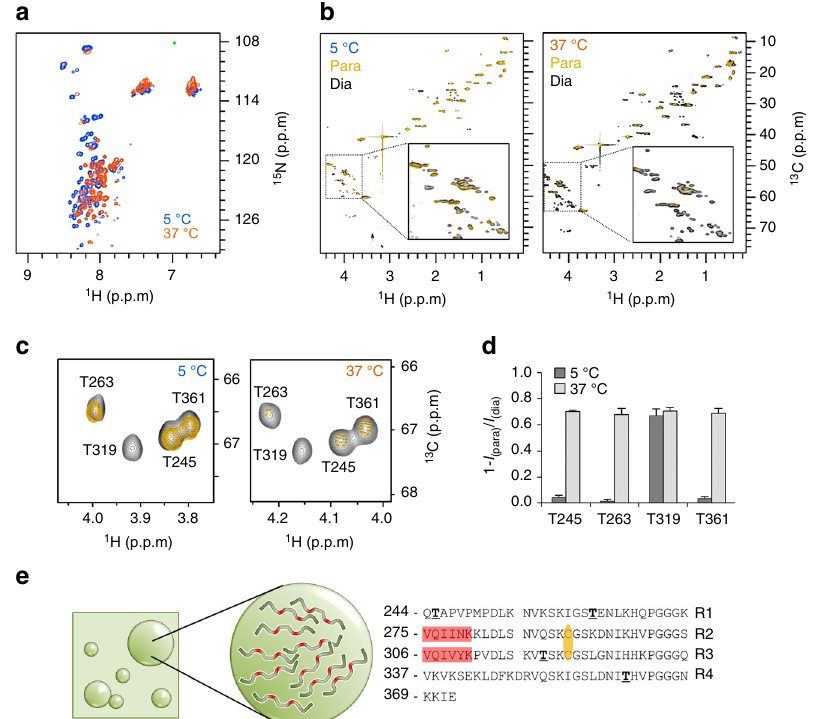
Fig. 5 Liquid demixing causes molecular crowding of amyloid hot spots of Tau. a Two-dimensional 1 H- 15 N HSQC spectra of the repeat domain of Tau (100 μ M of K18 in 50 mM sodium phosphate, pH 8.8, and 0.5 mM TCEP) in the monomeric dispersed ( blue ; 5 °C) and liquid demixed ( red ; 37 °C) state. Due to increased solvent exchange, many 1 H- 15 N cross-peaks of K18 are attenuated beyond detection at 37 °C 88 . In addition, an overall shift of the backbone resonances was observed, which is caused by the temperature dependence of NMR chemical shifts 52 . b Paramagnetic broadening in K18 (100 μ M; sodium phosphate; pH 8.8), which was tagged with the nitroxide tag MTSL at the two native cysteine residues C291 and C322, was quanti fi ed in 2D 1 H- 13 C HSQC spectra at 5 °C ( left ) and 37 °C ( right ). Paramagnetic and diamagnetic states are shown in gold and black , respectively. The C α -H α region of each spectrum is highlighted in the insets . c Selected region of the 1 H- 13 C HSQC spectra shown in b , highlighting paramagnetic broadening of the four threonine residues in K18. d Quanti fi cation of paramagnetic broadening observed in 1 H- 13 C HSQC spectra shown in b and c . Upon liquid demixing at 37 °C (100 μ M protein concentration; also see Fig. 2), 1 H- 13 C cross-peaks of T245, T263, T319, and T361 were strongly attenuated (1- I para / I dia ). In contrast, at 5 °C where K18 is present as dispersed monomer (Fig. 2), only T319, which is in direct proximity to the MTSL-carrying C322, was broadened. Error bars are calculated based on the signal-to-noise in the NMR spectrum of diamagnetic K18. e Schematic representation of molecular crowding of Tau ’ s aggregation-prone hexapeptides ( red ) in the interior of liquid droplets. The sequence location of the two hexapeptides and Tau ’ s native cysteine residues ( yellow ; attachment sites of MTSL) is shown on the right . Threonine residues are highlighted in